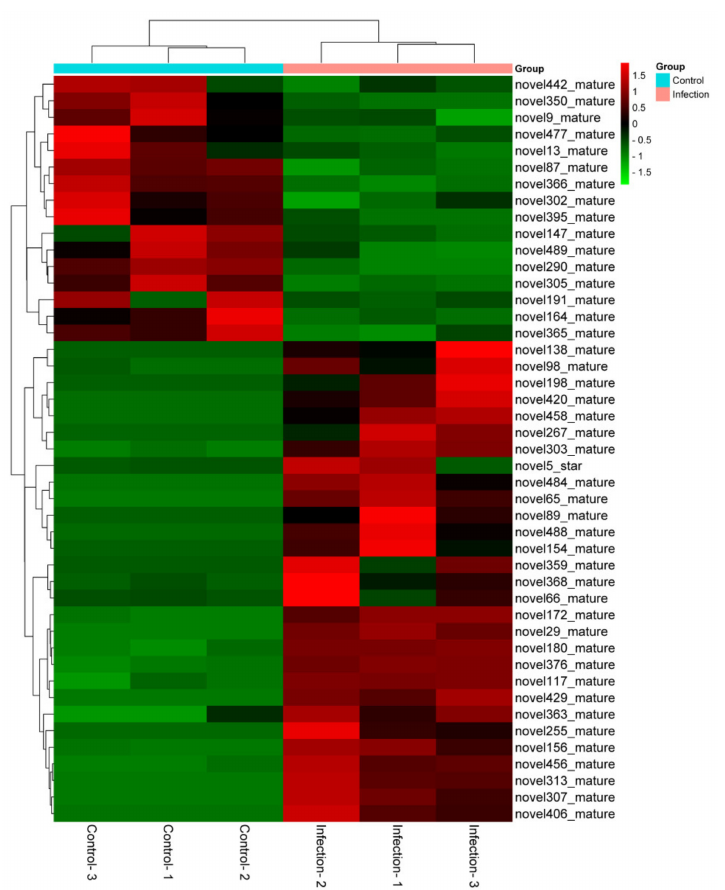
Figure 4. Using the R program, hierarchical clustering was used to determine novel miRNAs among PEDV-infected and control groups. Euclidean methods and complete linkage were used for this analysis. Upregulated and downregulated miRNAs are marked in red and green, respectively.